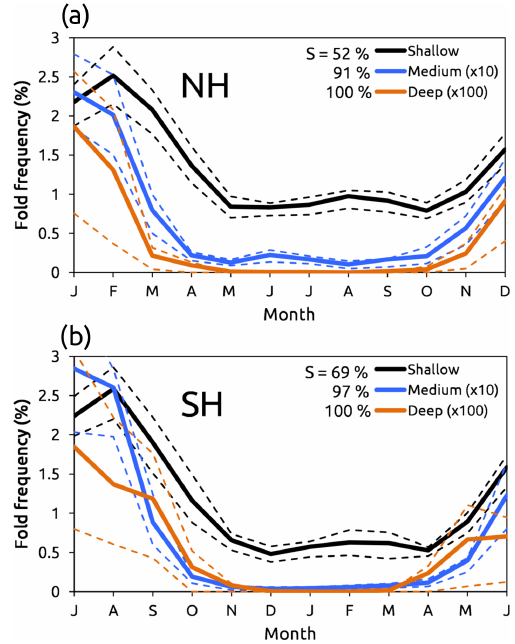
Figure 1. Seasonal cycle of tropopause fold frequencies (%) for (a) the NH (0–65 ◦ N) and (b) the SH (0–65 ◦ S) over the period 1979–2012 for intercomparison with Fig. 7 from Škerlak et al. (2015). The solid lines stand for the mean values, while the dashed coloured lines stand for the 25% and 75% percentiles. The season- of each seasonal cycle is also ality S = max − min max + min